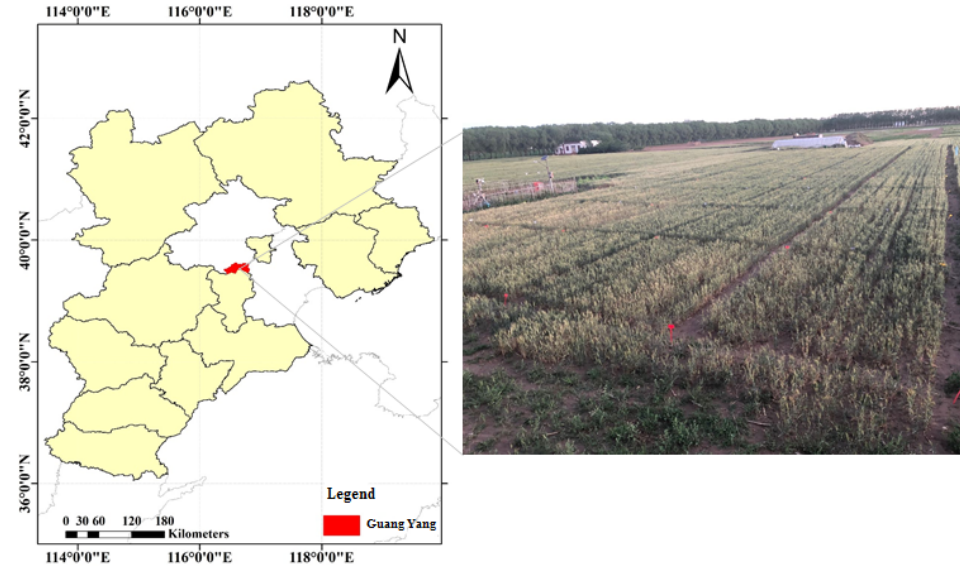
Figure 1. Overview of the study area.